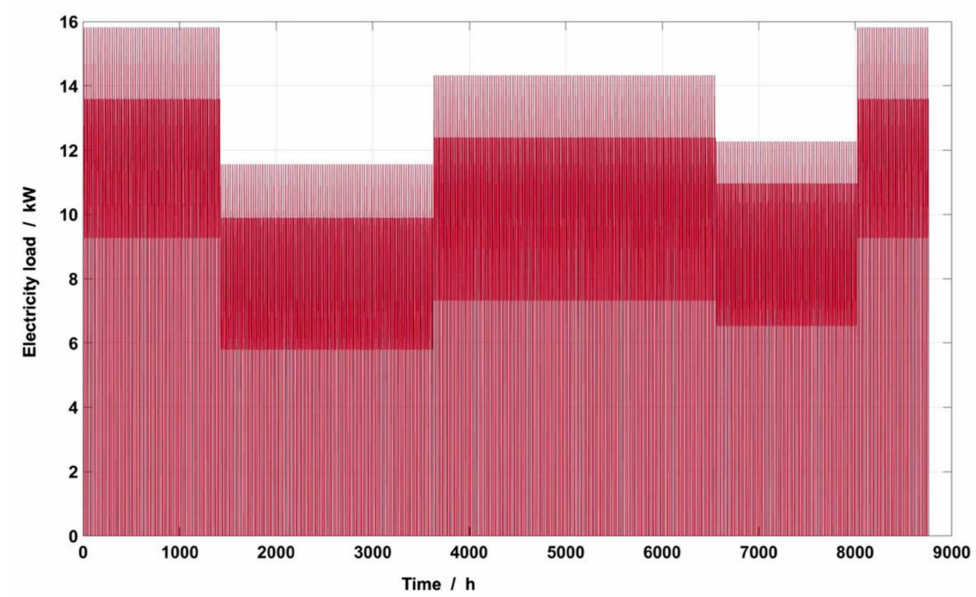
Figure 10. Annual hourly electricity load.